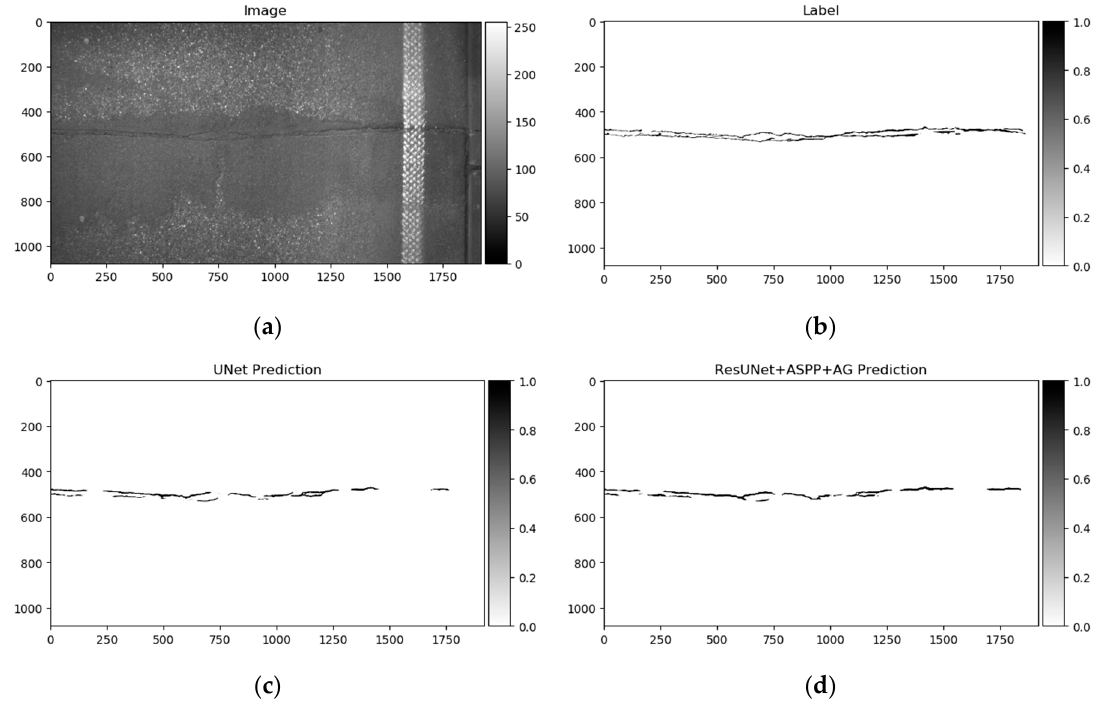
Figure 15. U-Net (baseline) and best performing solution—ResU-Net + ASPP + AG predictions on GAPs384 dataset sample. ( a ) Image, ( b ) label, ( c ) U-Net prediction, ( d ) ResU-Net + ASPP + AG prediction. ResU-Net + ASPP + AG architecture could capture more details compared to U-Net.